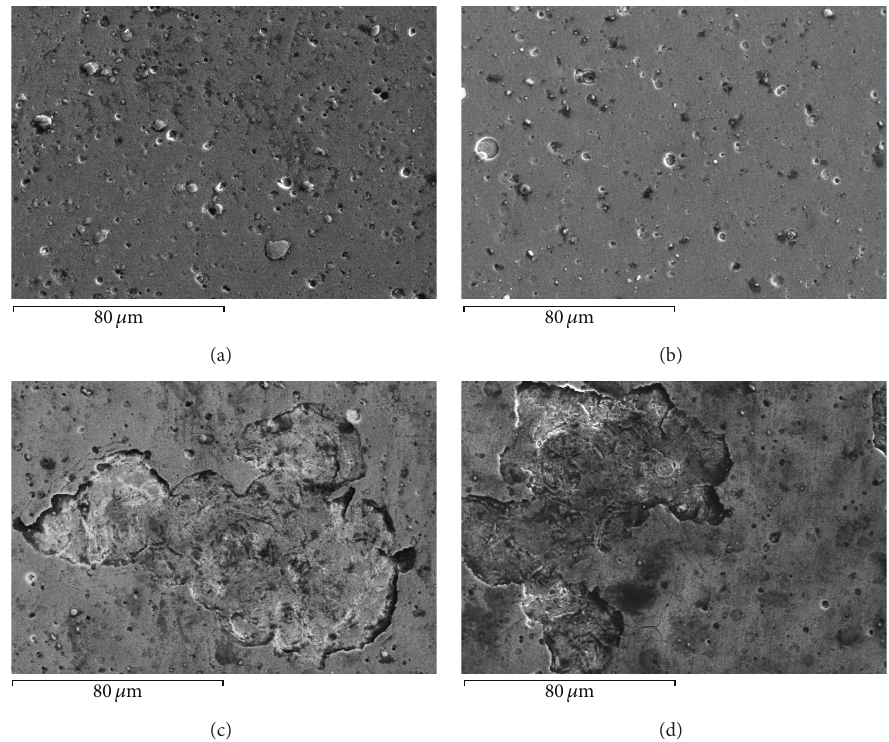
Figure 2: SEM analyses of the coating of CrN (a) and CrN + MB at 2 bar (b), 3 bar (c), and 6 bar (d).